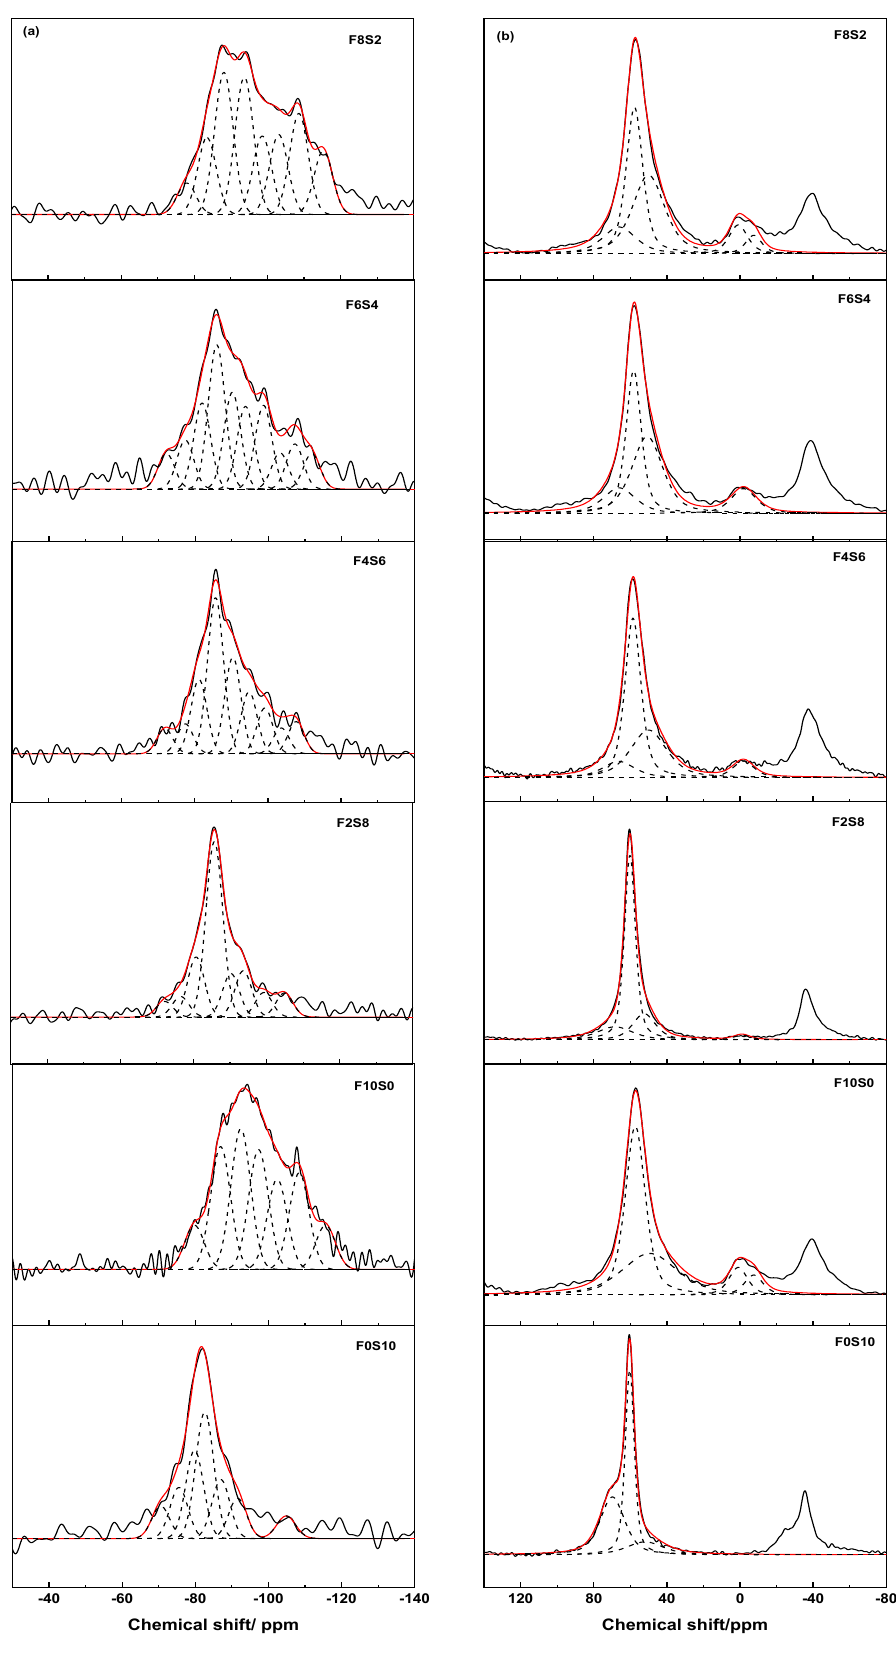
Figure 5. ( a ) 29 Si; and ( b ) 27 Al MAS-NMR spectra of the alkali-activated mixtures.